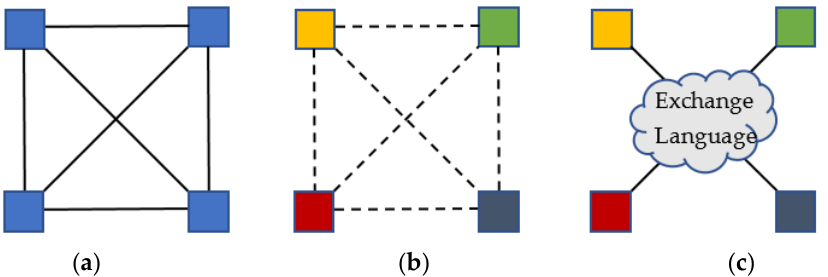
Figure 9. Basic architectures for information interoperability (adapted from [39]): systems of the same type ( a ), systems of different type, no information standardization ( b ), systems of different type, one common information standard ( c ).